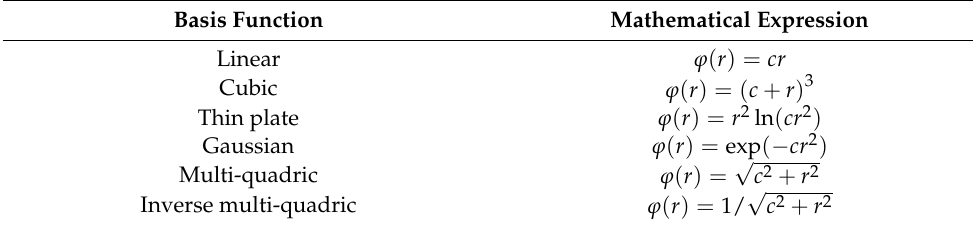
Table 1. RBF common basis